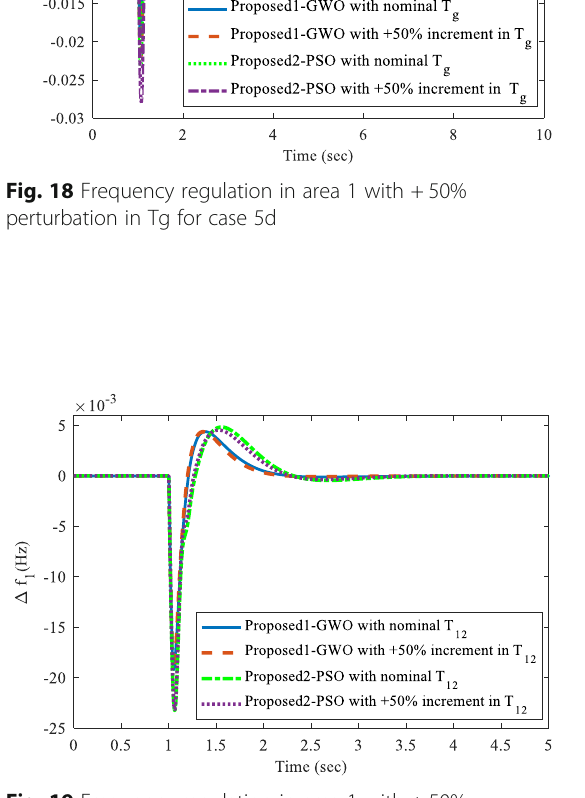
Fig. 19 Frequency regulation in area 1 with + 50% perturbation in T 12 for case 5d